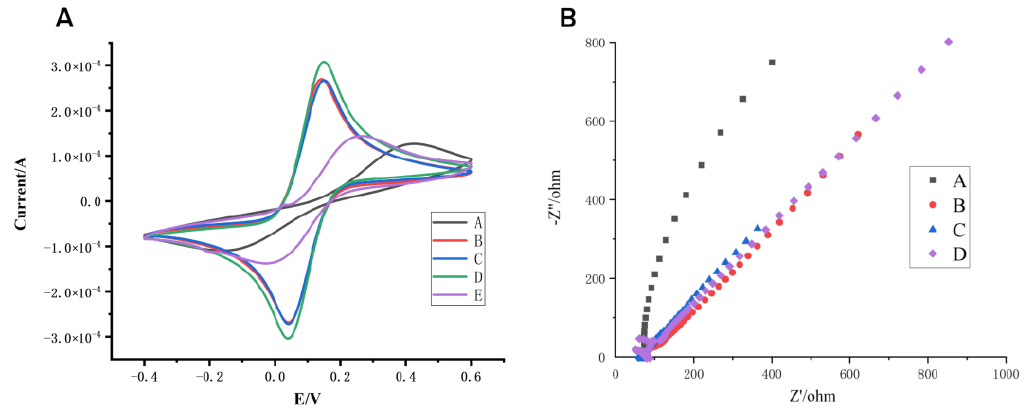
Figure 2. Structural characterization of the sensor in 5.0 mmol/L [K 3 Fe(CN 6 )] solution in 0.1 mol/L KCl. ( A ) Cyclic voltammogram (CV): A bare electrode CV (bare SPCE), B electrode after deposition